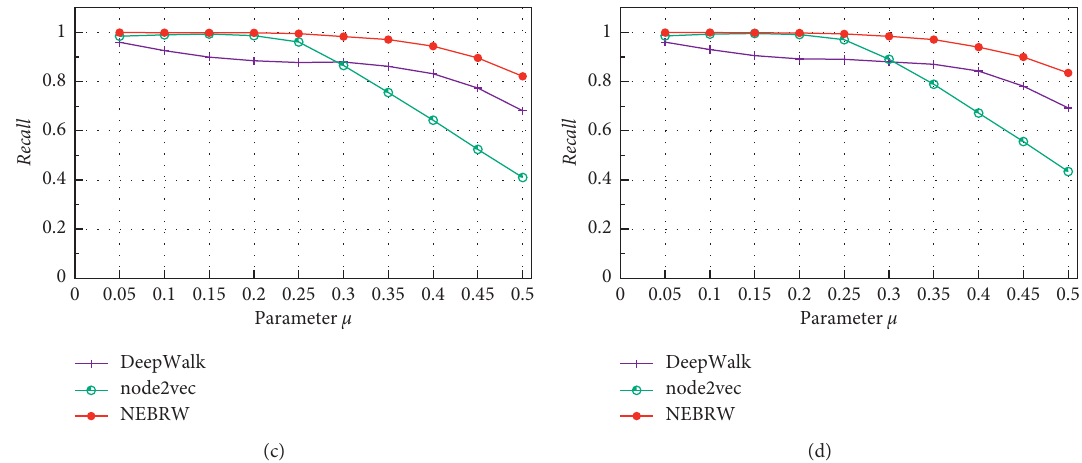
Figure 5: Comparison results on LFR networks with node embedding baselines. (a) Comparison results on LFR5K. (b) Comparison results on LFR10K. (c) Comparison results on LFR30K. (d) Comparison results on LFR50K.